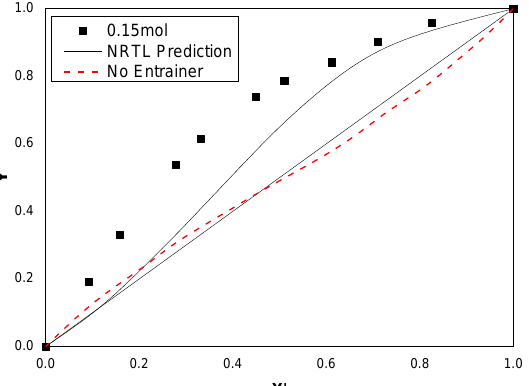
Figure 12. Experimental and calculated data X’Y diagram for cyclohexane (1) + benzene (2) + DES (3) at constant pressure (101.325 kPa) and constant DES molar fraction ( X 3 = 0.15).